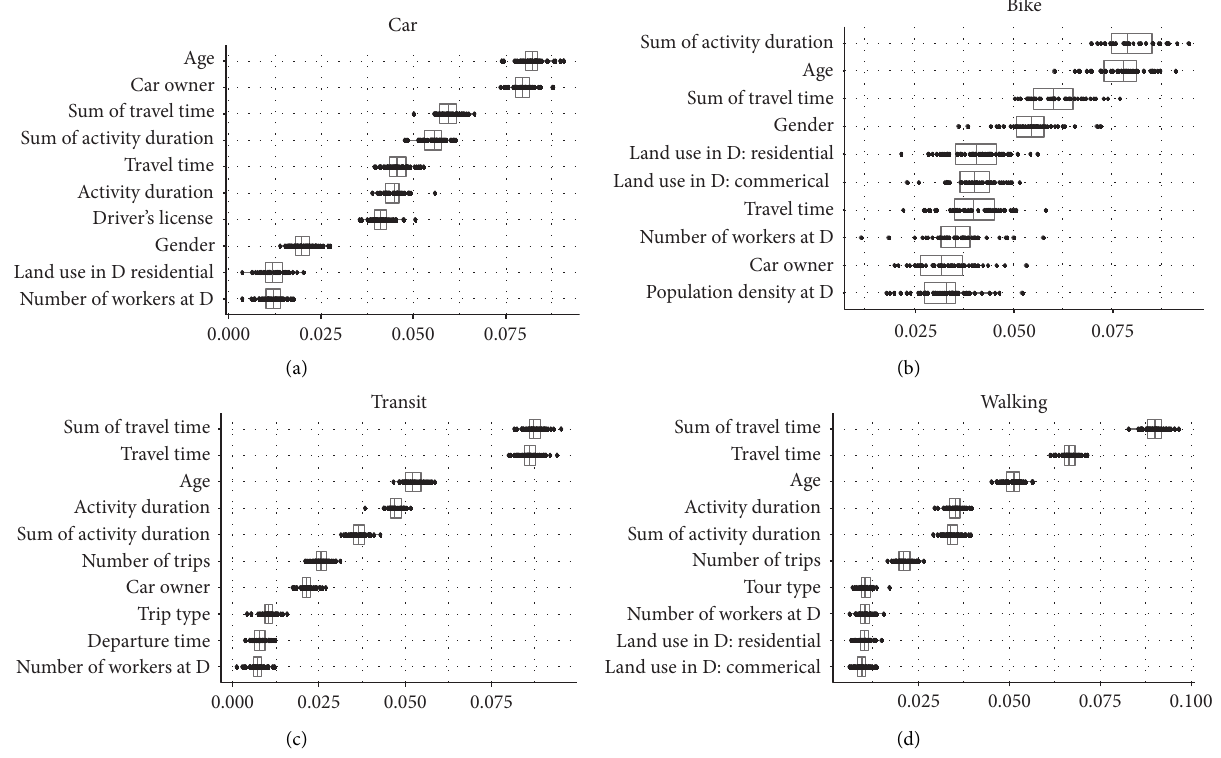
Figure 1: Permutation-based variable importance for each travel mode choice: (a) car, (b) bike, (c) transit, and (d) walking.